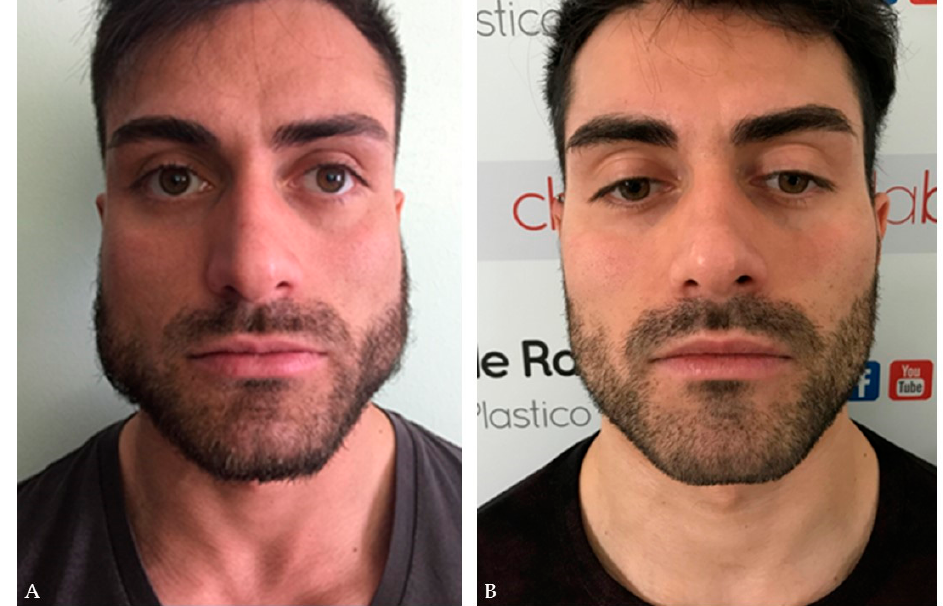
Figure 4. ( A ) A patient before BoNTA injection. ( B ) Follow-up of the patients after 6 months from the injection.